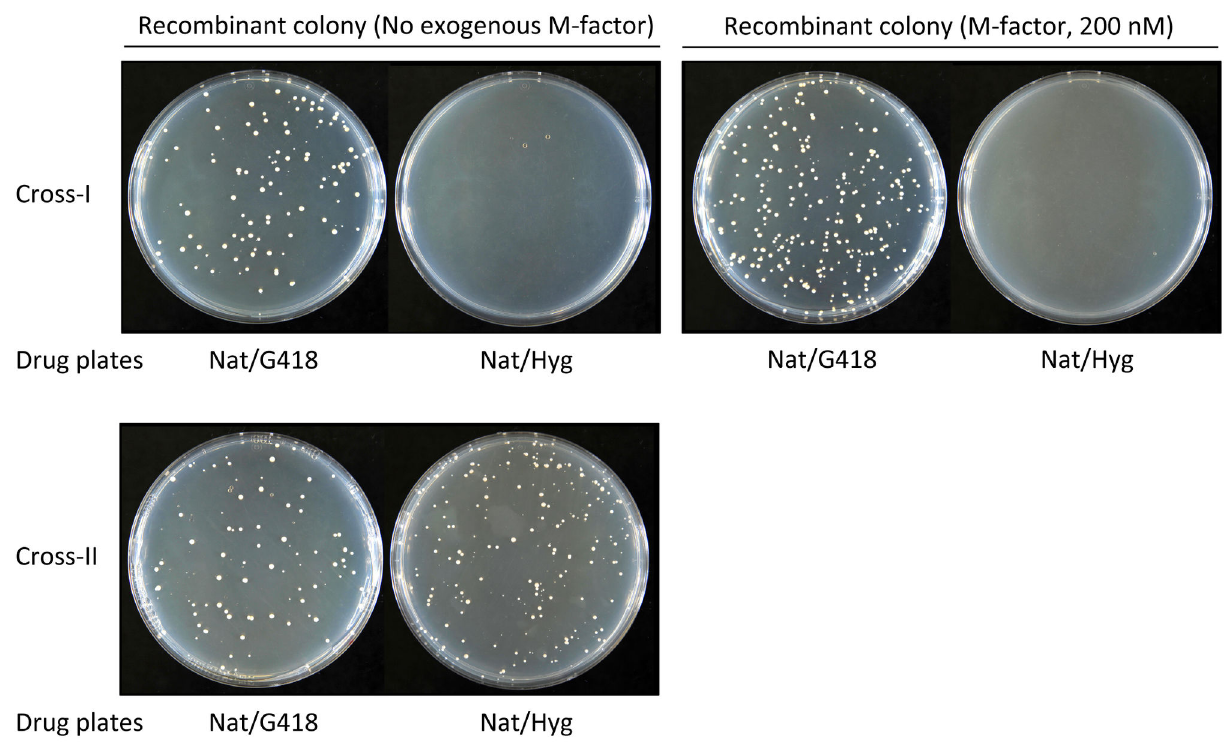
Figure 7. Recombinant frequency assay of wild-type and pheromone-less mutant strains. Heterothallic haploid strains carrying a natR , kanR or hygR drug-resistant marker were cultured in SSL+N overnight and then mixed in the nitrogen-free conjugation medium (SSL−N) with or without M-factor (200 nM), and cultured at 28 o C with shaking. Two different mixed cultures ran in parallel. Cross-I, P-type strain (FS404; P WT , natR ), M-type strain (FS357; M WT , kanR ) and M-type pheromone-less mutant (FS419; M phe-less , hygR ). Cross-II, P-type strain (FS404; P WT , natR ), M-type strain-1 (FS357; M WT1 , kanR ) and M-type strain-2 (FS423; M WT2 , hygR ). The same number of cells of the two M-type strains and twice the number of cells of the P-type strain were mixed. After incubation for 2 days, the cultures were diluted and then spread onto YEA plates containing 100 µg/ml of the appropriate drug: YEA +Nat, YEA+Nat+G418, and YEA+Nat+Hyg. After 3 days of incubation, the plates were photographed. The colony number on the plates was